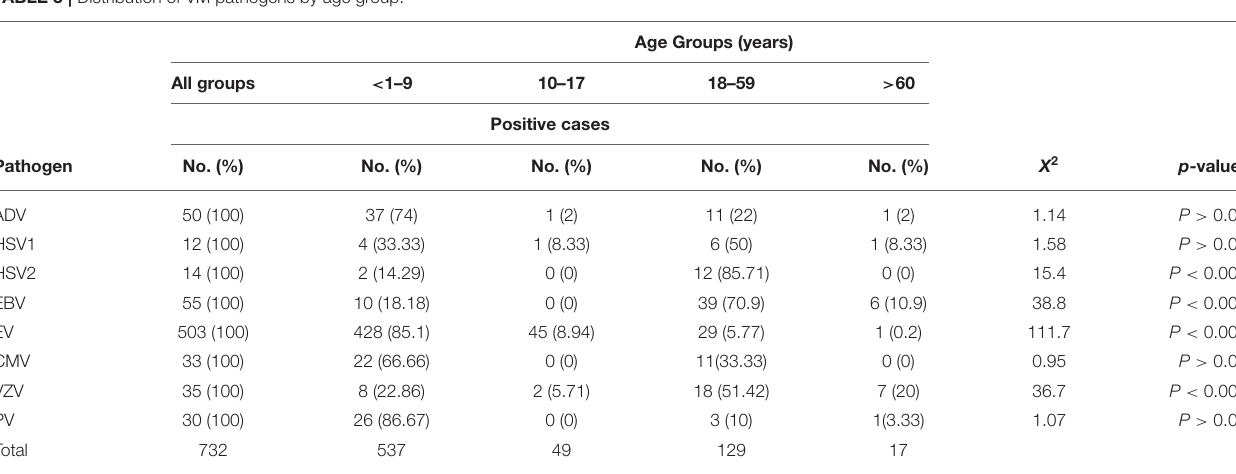
TABLE 3 | Distribution of VM pathogens by age